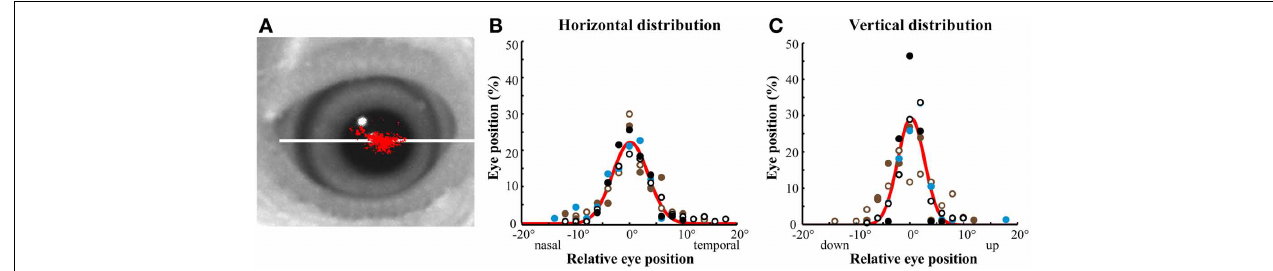
FIGURE 2 | Optically recorded eye position distributions. (A) Representative distribution of eye positions in a head-immobilized bird during a single session measured with the optical eye tracker. Each red dot represents a sampled eye position. The distribution of eye movements was most extensive along the horizontal, vergence axis of the eye (white line). (B,C) Distributions of eye position in head-immobilized birds measured with the optical eye tracker. The eyes made small excursions from a median eye